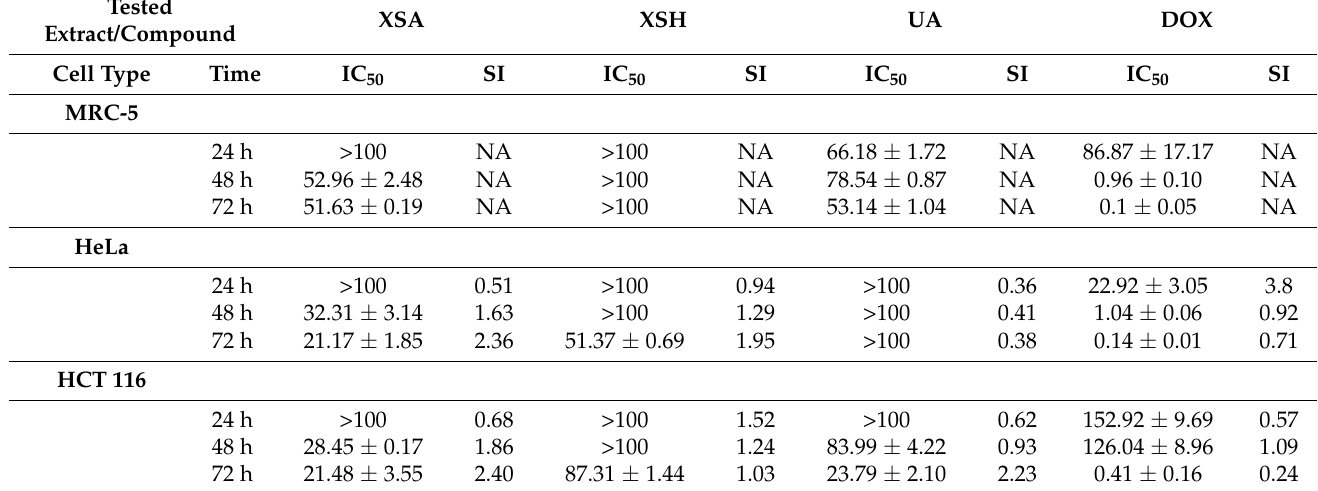
Table 9. IC 50 ( µ g/mL) values determined by MTT assay for XSA, XSH, UA, and doxorubicin after 24, 48, and 72 h of treatment of MRC-5, HeLa, and HCT 116 cells and SI